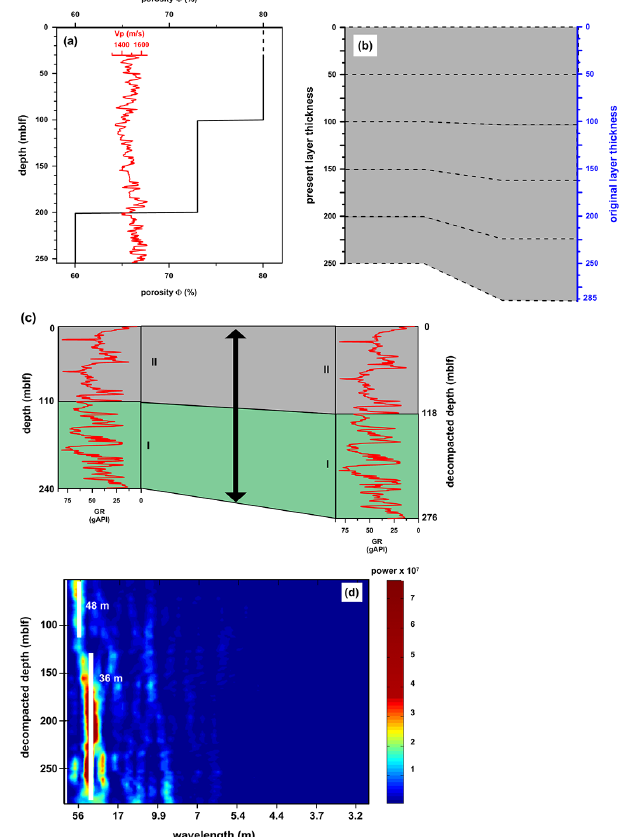
Figure 5. (a) Porosity values derived from sonic ( V p ) after Erick- son and Jarrard (1998) from 30 to 250mb.l.f. Average values for intervals of 100m length were calculated as indicated by the black line and values for the top 30m of the sediments were linear inter- polated (dashed black line). An initial porosity (surface porosity) of 80% was used for modelling of compaction by 2DMove. (cid:56) – porosity; V p – p wave velocity from sonic. (b) Sediment layers of thicknesses of 50m are modelled applying the software 2DMove. The cumulative present layer thickness of 250m is extended after decompaction to 285m (original layer thickness). (c) The GR data from 0 to 240mb.l.f. and the intervals from subdivision by spectral characteristics at about 110mb.l.f. (left). The data were stretched to the estimates of the original layer thickness. The decompacted depth and new interval borders are displayed (right). (d) Result from slid- ing window analysis of GR data on decompacted depth scale. Two spectral peaks with wavelengths of 36 and 48m are